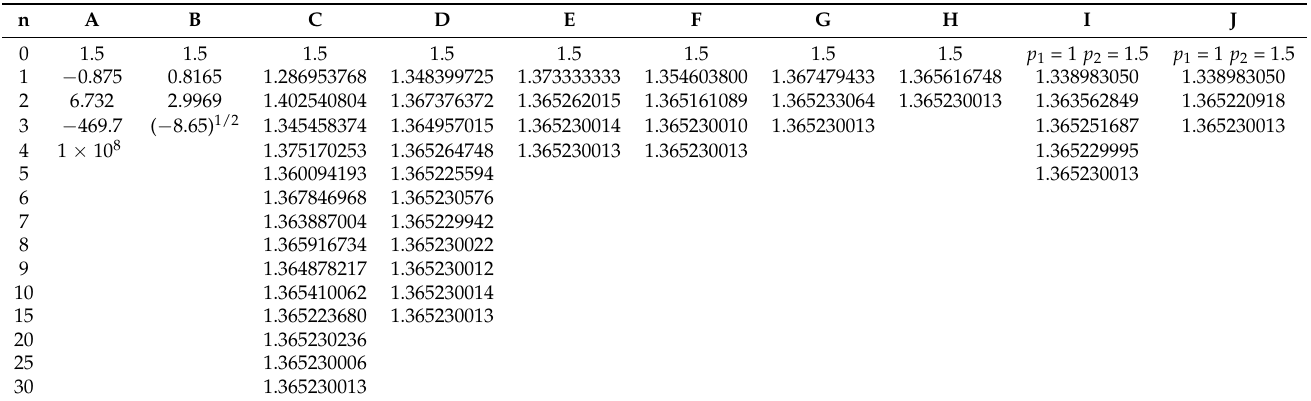
Table 1. Comparison of the results obtained for EFPM with other fixed point